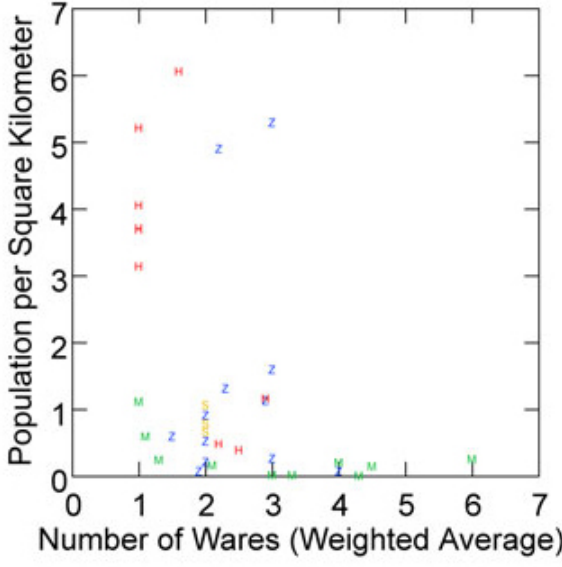
Fig. 9 . Population density and ceramic ware diversity values for all time-space units, with region indicated by letter and color. H = Hohokam, M = Mimbres, S = Salinas, Z =